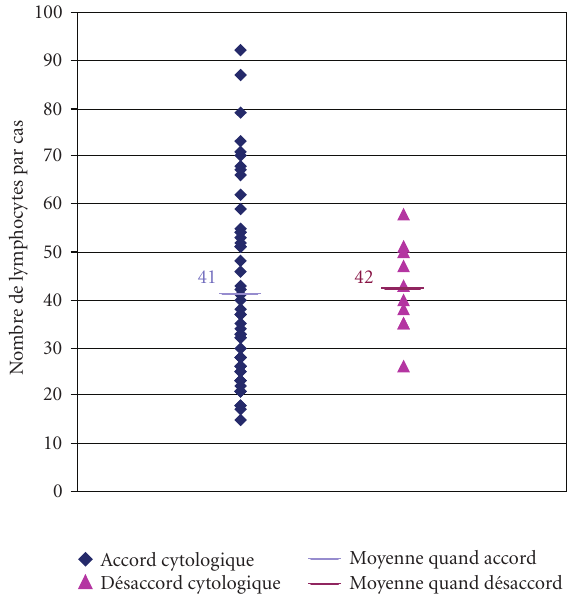
Figure 7: Average numbers of captured lymphocytes functions of cytological concordance.